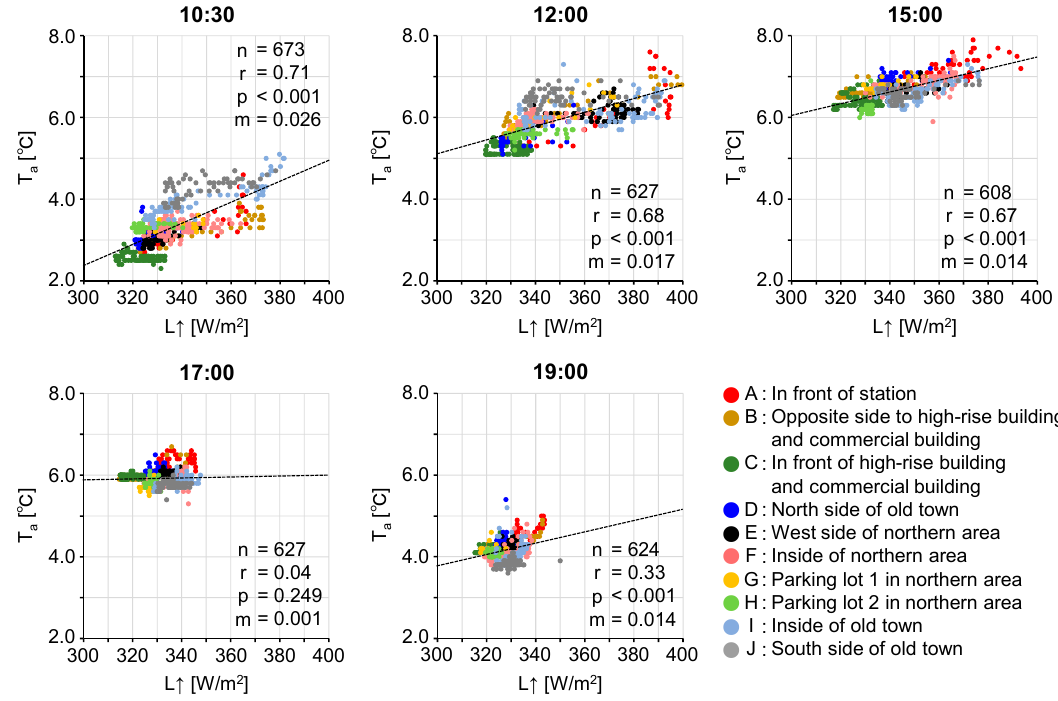
Figure 10. Scatter-plots of upward long-wave radiation (L ↑ ) and air temperature (T a ) derived from mobile observation.